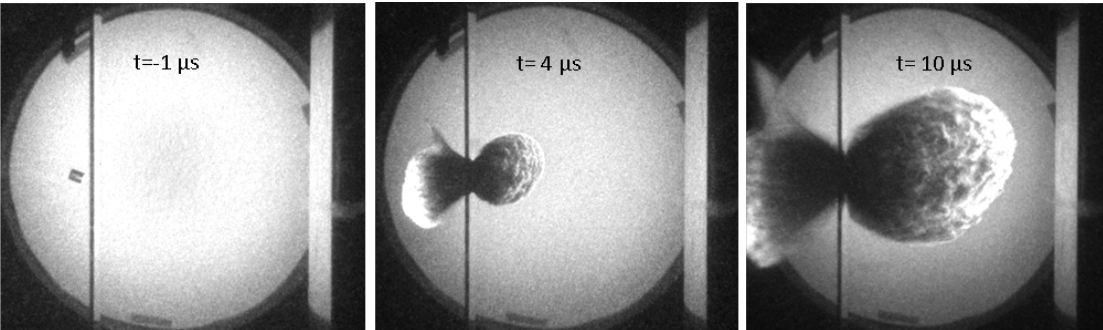
Figure 1. High-speed photograph sequence of HVI performed at Fraunhofer Ernst–Mach–Institut [8]. A cylindrical impactor approaches from the left, collides with the target plate, and the resulting debris cloud propagates to the